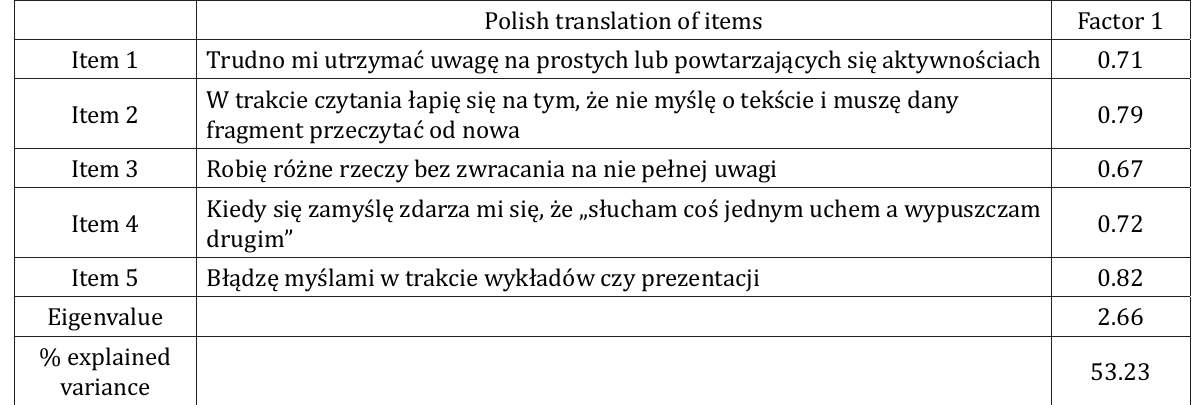
Table 4. contains Polish translation of the scale and the result of exploratory factor analysis. First of all, this analysis confirmed that scale in Polish version is single- factorial, all items significantly loaded the factor. The Eigenvalue was 2.66 and the factorial load explained 53.23 percent of total variance.